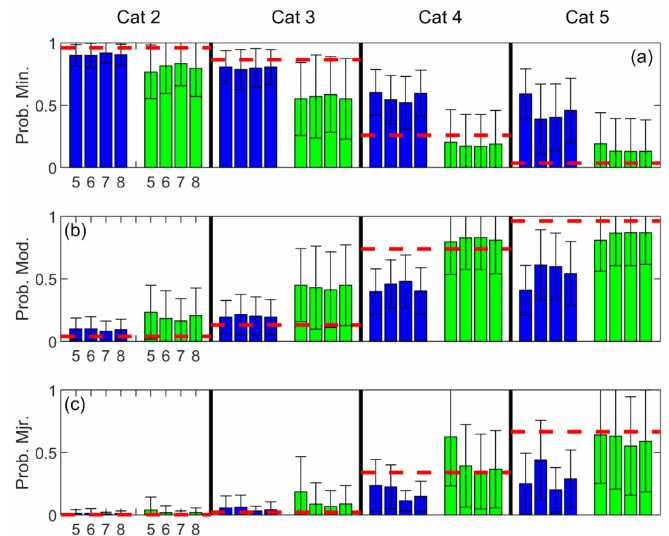
Figure 13. Comparison of Weibull (green/right) and log-normal (blue/left) models by storm category (vertical columns). Each subplot corresponds to a damage classification: ( a ) Minimal; ( b ) Moderate; ( c ) Major. Each vertical bar corresponds to an EDP case and model. Note only EDPs 5–8 are shown. Whiskers are standard deviation in predicted probabilities for the corresponding category of storms. Dashed red horizontal bar is the actual observed fraction corresponding to the appropriate storm category.